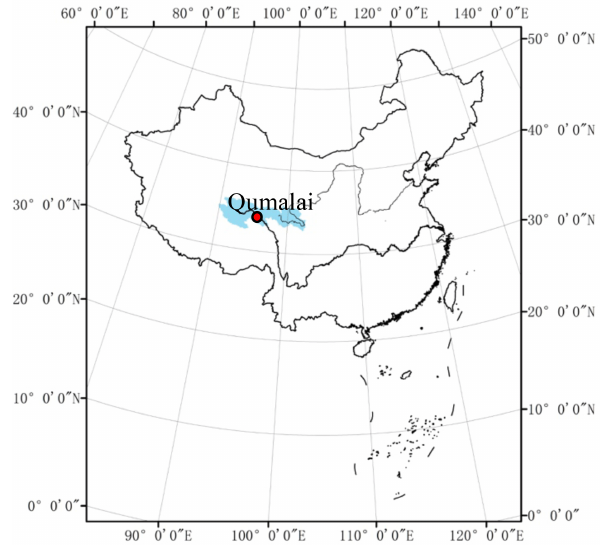
Figure 1. Distribution of observation site in the Three–River Source